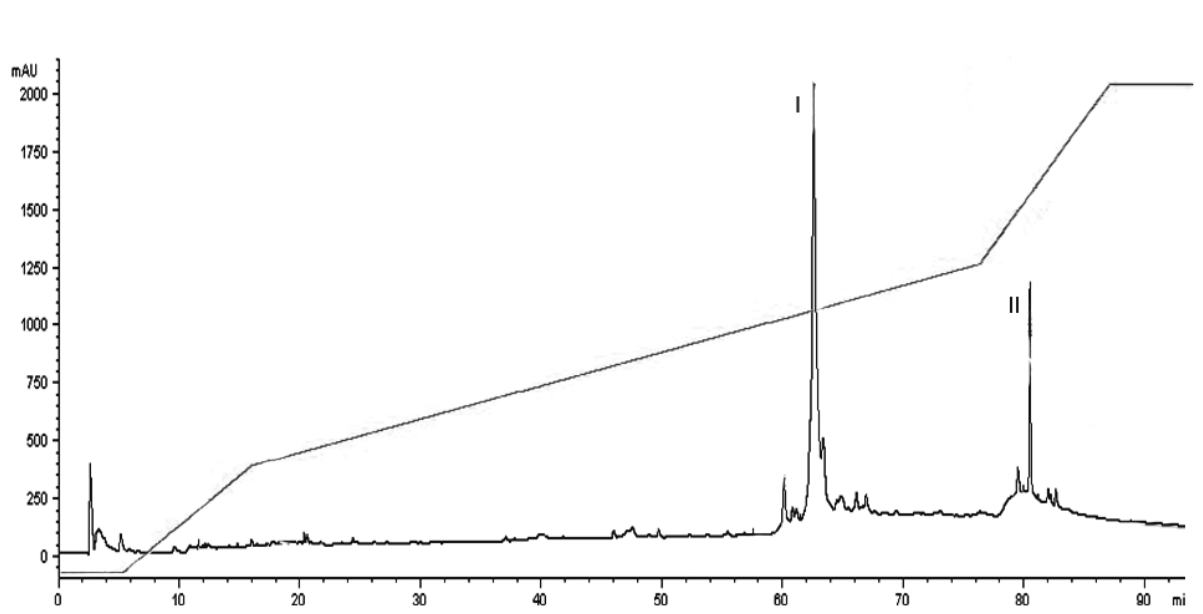
Figure 3. Reverse HPLC of La SF ( Lachesis acrochorda specific fraction). Fraction La SF was loaded into a C column using an Agilent 1200 chromatograph (USA). Elution was performed at 1 mL/minute by applying acetonitrile gradient containing 0.1% TFA. Absorbance was monitored at 215 nm; fractions were manually collected and dried in a vacuum centrifuge (Savant, USA). Peak I was identified as a Gal-specific lectin and peak II as a